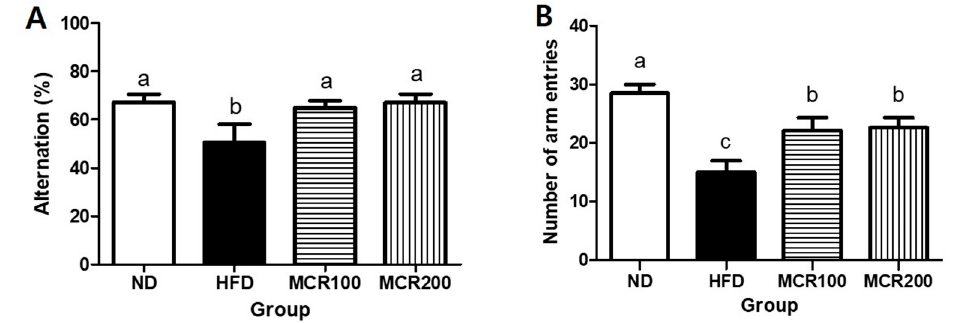
Figure 3. Effect of Mori Cortex radicis extract (MCR) on spontaneous alternation behavior in HFD-induced mice. ( A ) Spontaneous alternation and ( B ) number of arm entries. Mice were fed ND or HFD with or without MCR (100 or 200 mg/kg b.w.) for 14 weeks. At 14 weeks, Y-maze behavioral test was then performed. Results are presented as means ± SDs ( n = 8). Statistical significance was accepted for p values < 0.05. Small letters indicate significantly different from other groups.